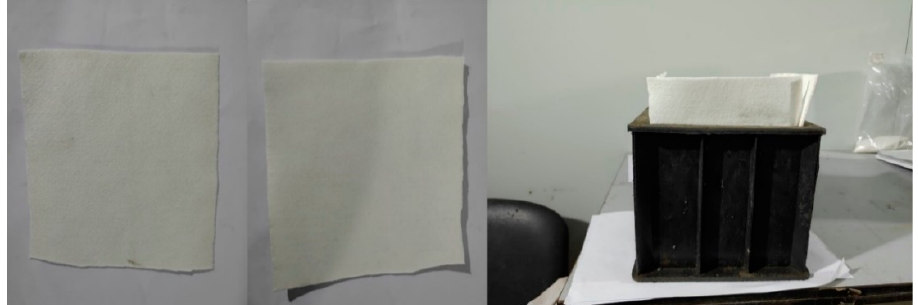
Figure 4. Appearance of the controlled permeable formwork liner.